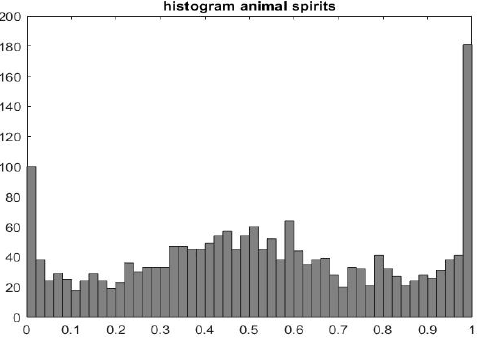
Figure 2. Histogram of the frequency distribution of the degree of animal spirits for the model under study with an imperfect labor market at a value λ w = 0.1.